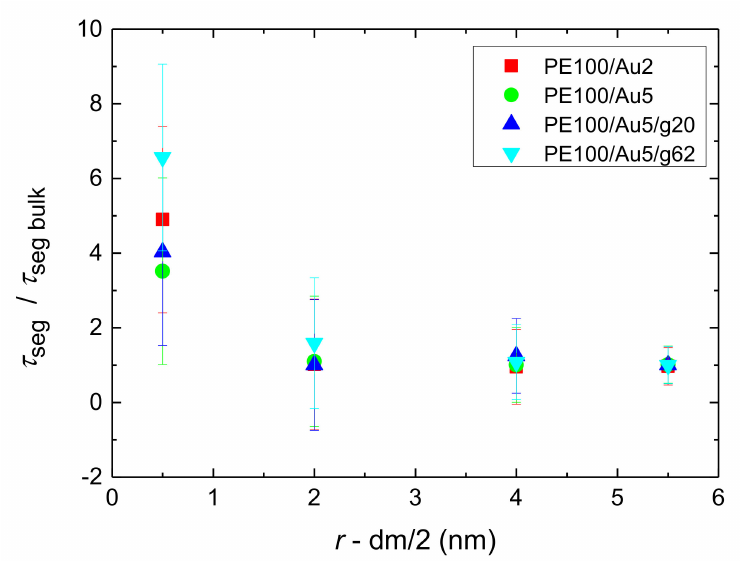
Figure A7. Segmental relaxation times of PE chains, scaled with the value of bulk chains, τ seg / τ seg bulk , as a function of distance from the center of the Au NP, r , minus the half diameter of the NP, for all systems with PE matrices consisting of 100 mers per chain.